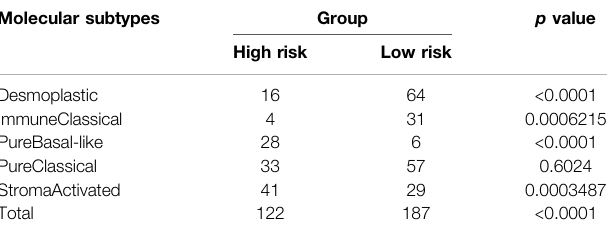
TABLE 3 | Association between the IRGS and fi ve molecular subtypes. Molecular